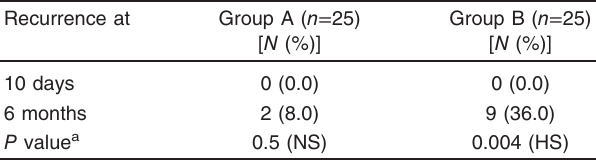
Table 4 Comparison of adenoid recurrence development in each group